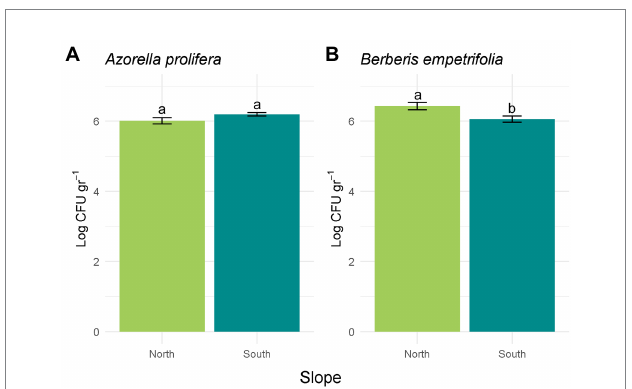
FIGURE 3 Bacterial abundance calculated in Log CFU g − 1 for A. prolifera (A) and B. empetrifolia (B) soil. Values indicate average ± SE ( n = 3). Letters indicate significant differences between slopes (Wilcoxon test, p >